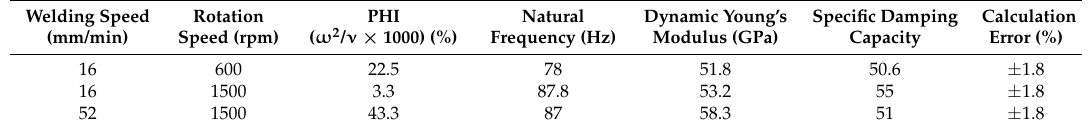
Table 3. The dynamic properties of defective welds.